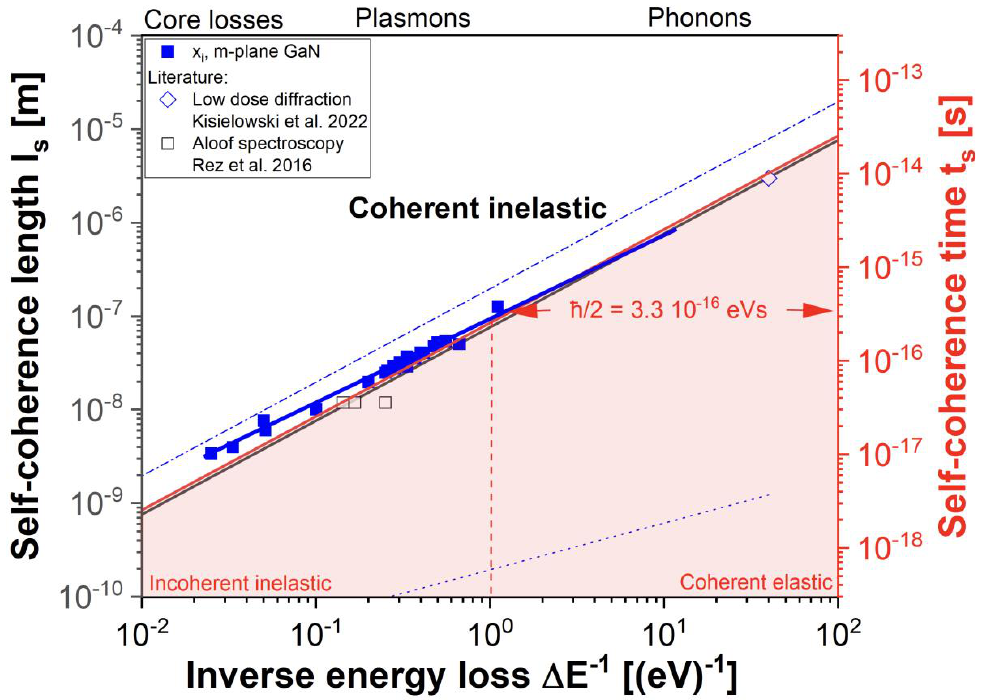
Figure 7. Spatial (black) and temporal (red) self-coherence versus inverse energy loss. Heisenberg’s uncertainty principle was revealed by choosing ∆ ϕ = 0.5 rad for the self-interference of coexisting incident and scattered wave functions [12]. Measured penetration depth values x i (squares) and results from [17,27] (open symbols). They were compared to the self-coherence lengths l s (black line), the tunneling distances l t (dotted blue line), and the extension of evanescent fields l e created by wave packets traveling at the speed of light, 197 eVnm = ¯ hc (dash-dotted blue line), and at 54% of the speed of light, ¯ hv = 106 eVnm (solid blue line). The abrupt coherence loss around 1 eV (dashed red line) separated modeling by either coherent–elastic or incoherent–inelastic scattering events in theoretical considerations [3–5]. Experimentally, no such difference seems